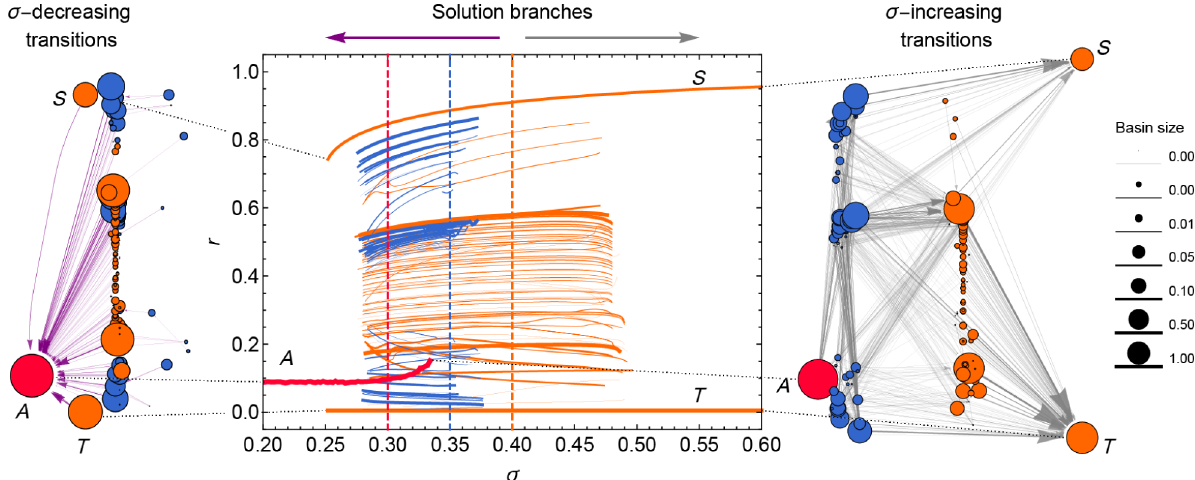
FIG. 3. Main panel: Stable solution branches in the space defined by order parameter r vs coupling strength σ . The line thickness indicates the size in the logarithmic scale of the corresponding basins of attraction, determined from 10 4 random initial conditions at σ ¼ 0 . 30 (red lines), σ ¼ 0 . 35 (blue lines), and σ ¼ 0 . 40 (orange lines). Side panels: Networks of transitions between solution branches in the forward (right) and backward (left) directions, generated by quasistatically increasing and decreasing σ , respectively. The nodes represent solution branches, color coded as in the main panel, and with the radius representing the logarithmic size of the attraction basin, while the width of the directed links indicates the relative transition probability (i.e., the transition probabilities between branches times the logarithm basin size of the initial state). The node positions indicate the respective positions of left (right) ending points of solution branches in the left (right) panels, and reference asynchronous, synchronous, and twisted states are labeled with A , S , and T , respectively, with dotted lines showing the correspondence between the